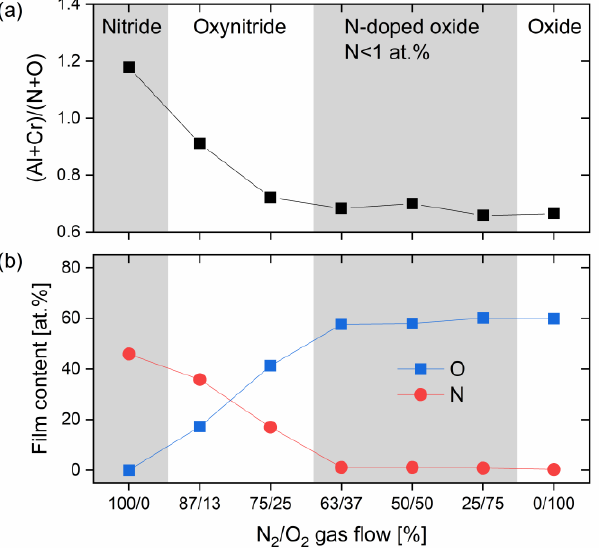
Figure 24. ( a ) Al + Cr to N + O ratio ( b ) N and O content in Al-Cr-O-N coatings for different N 2 /O 2 reactive gas mixtures, redrawn after [166], original © Elsevier.